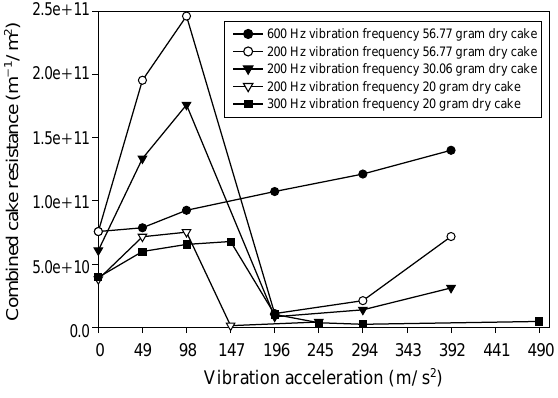
Fig. 14 Combined cake resistance for various masses of cakes under different vibration acceleration and frequency con- ditions during permeation experiments.